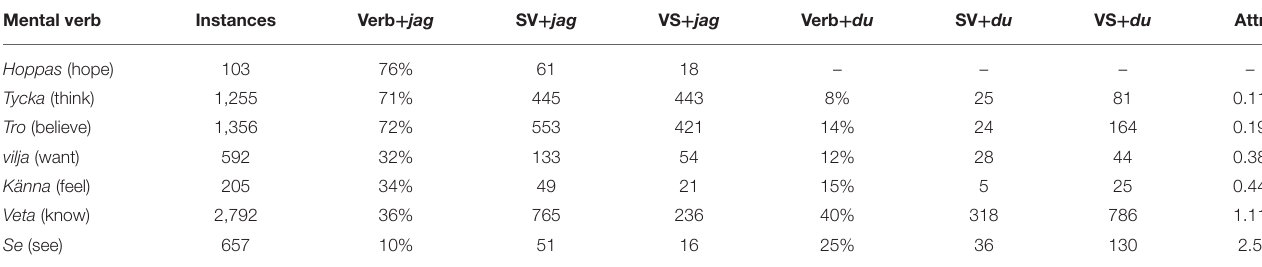
TABLE 4 | Distribution of mental and sensory verbs with jag/du and SV/VS constituent order. Mental verb Instances Verb + jag SV + jag VS + jag Verb + du VS + du Attr Hoppas